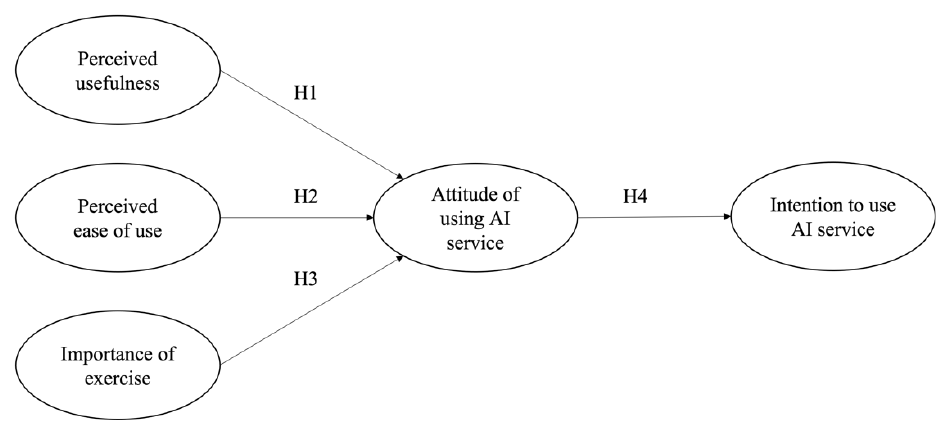
Figure 1. Hypothesized model of this study.